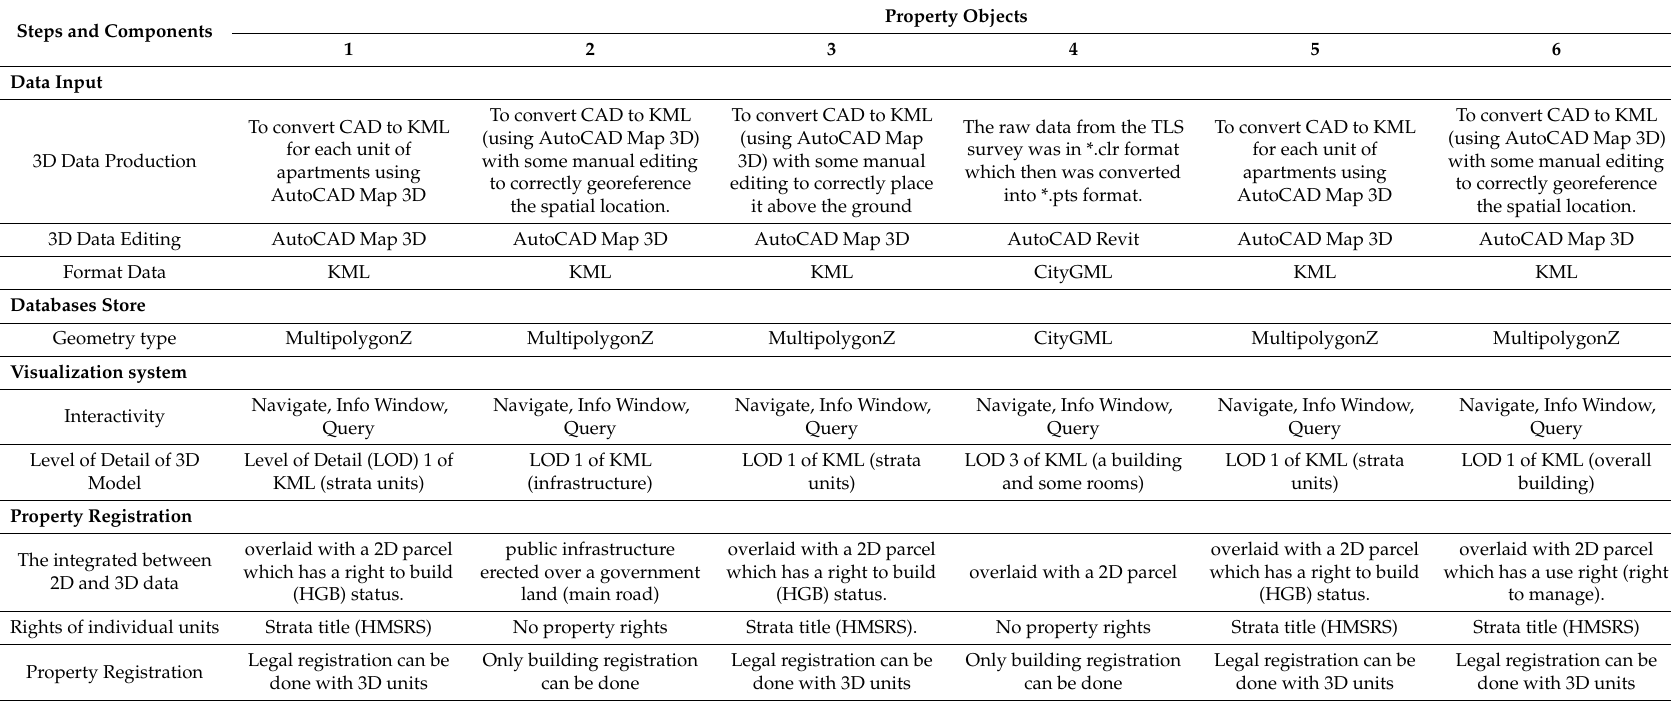
Table 5. Review of registration steps and